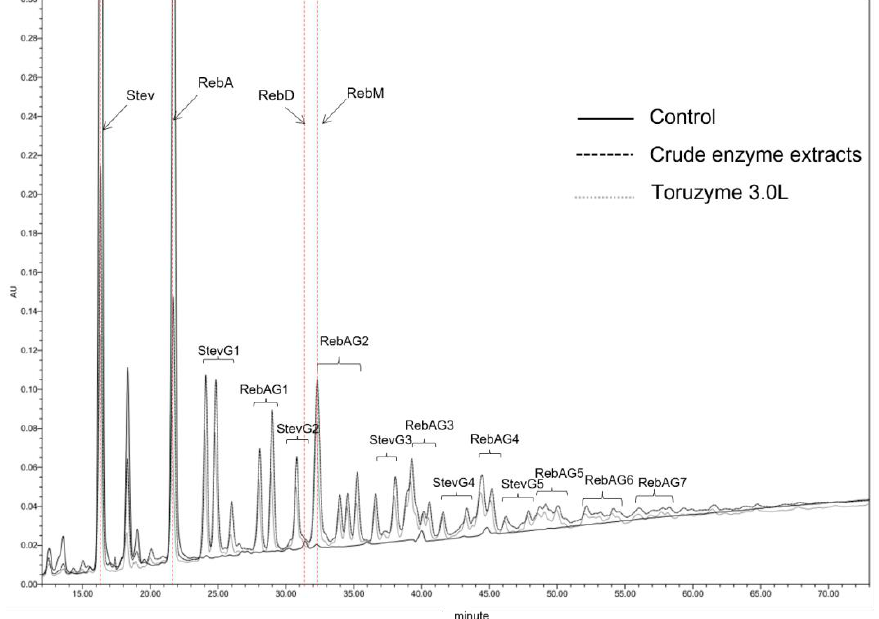
Figure 2. HPLC spectrum profiles of steviol glycosides and enzymatically modified steviol glycosides.